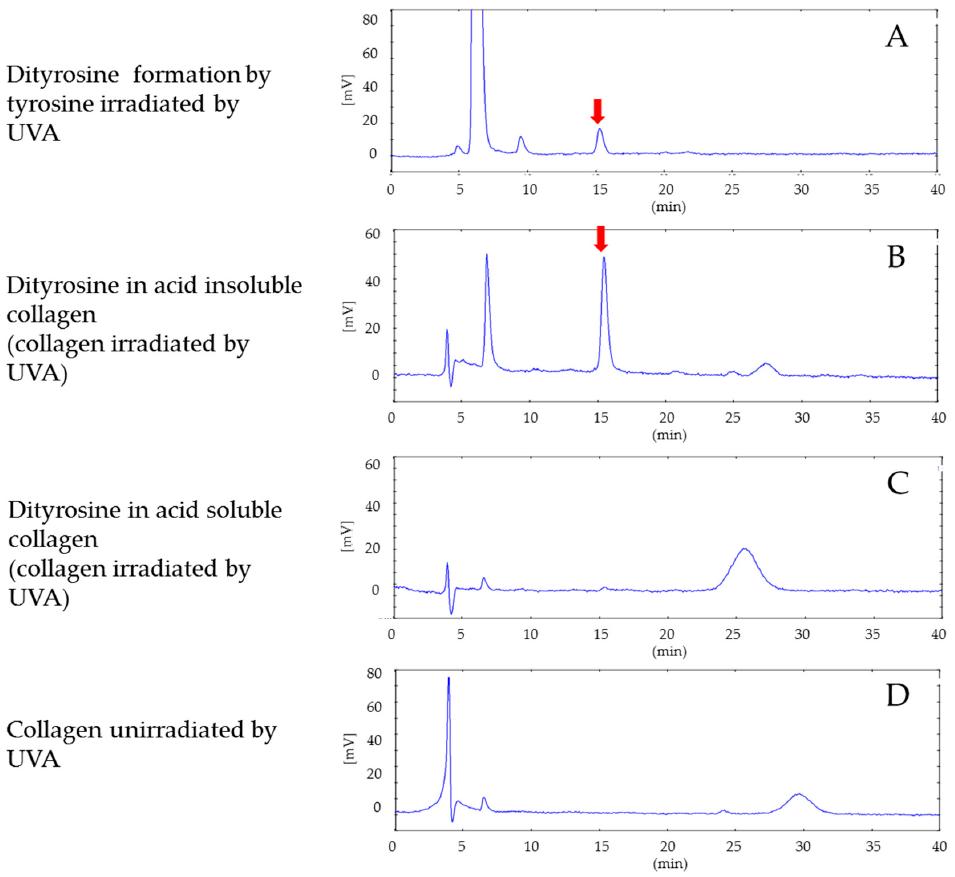
Figure 8. HPLC analysis of dityrosine in collagen gels irradiated by UVA ( A ) Dityrosine formation by tyrosine irradiated by UVA; ( B ) Dityrosine in acetic acid-insoluble collagen (collagen irradiated by UVA); ( C ) Dityrosine in acetic acid-soluble collagen (collagen irradiated by UVA); and ( D ) Collagen not irradiated by